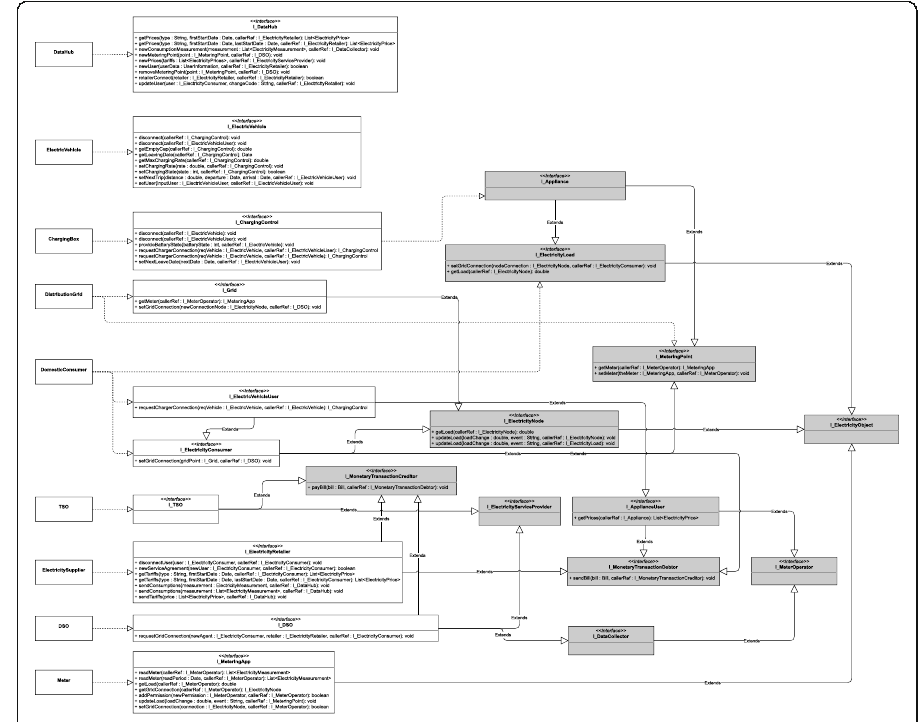
Fig. 10 Hierarchy of agent types and interfaces in the case study